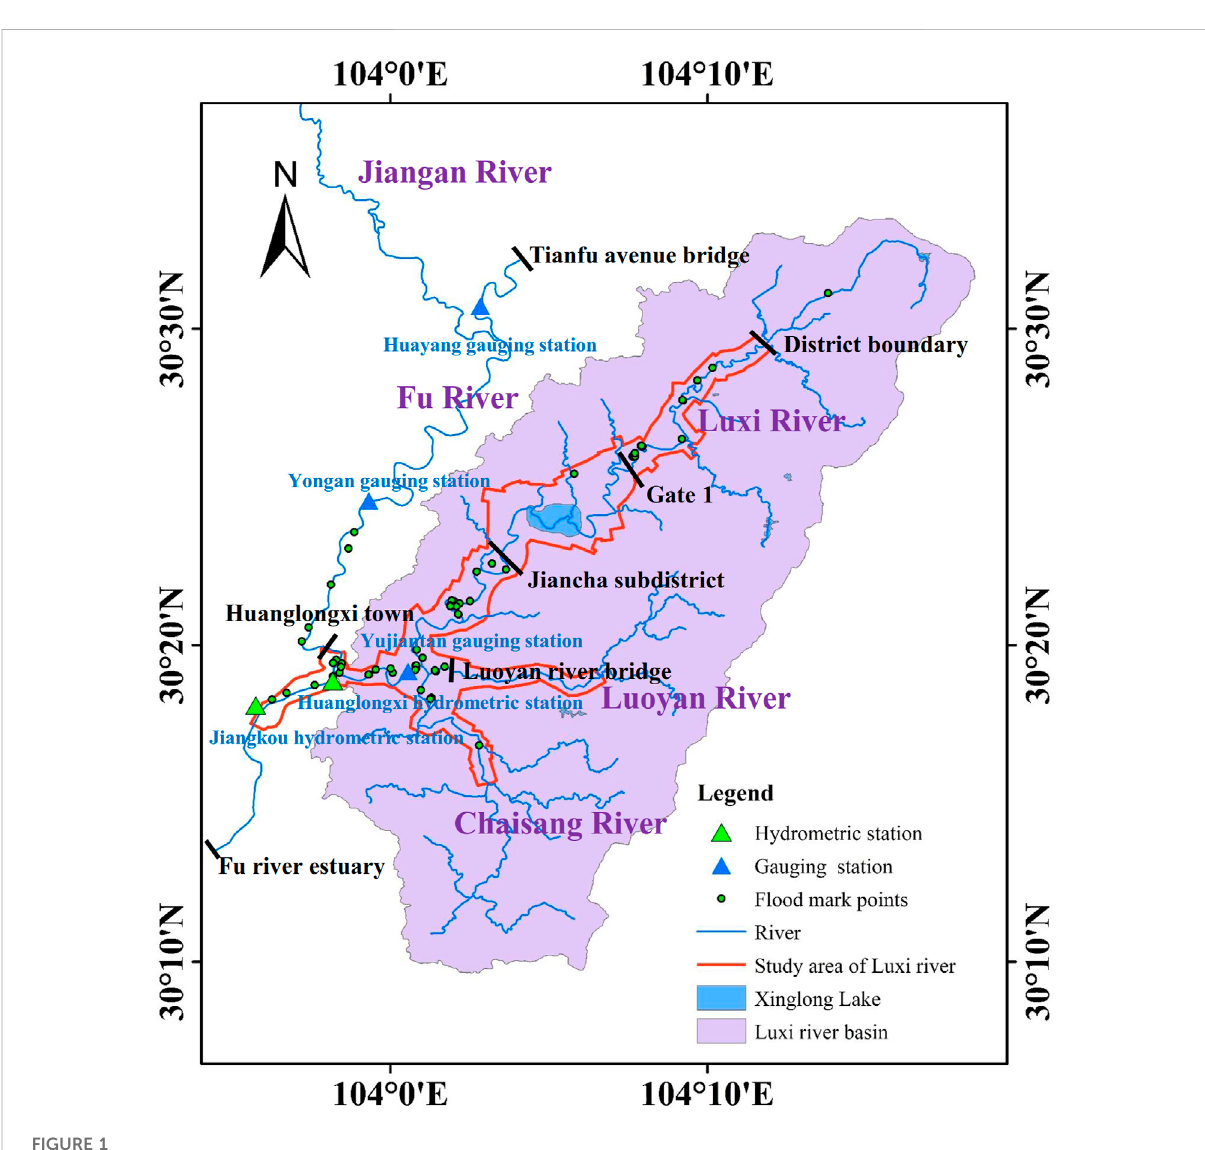
FIGURE 1 Schematic diagram of the study